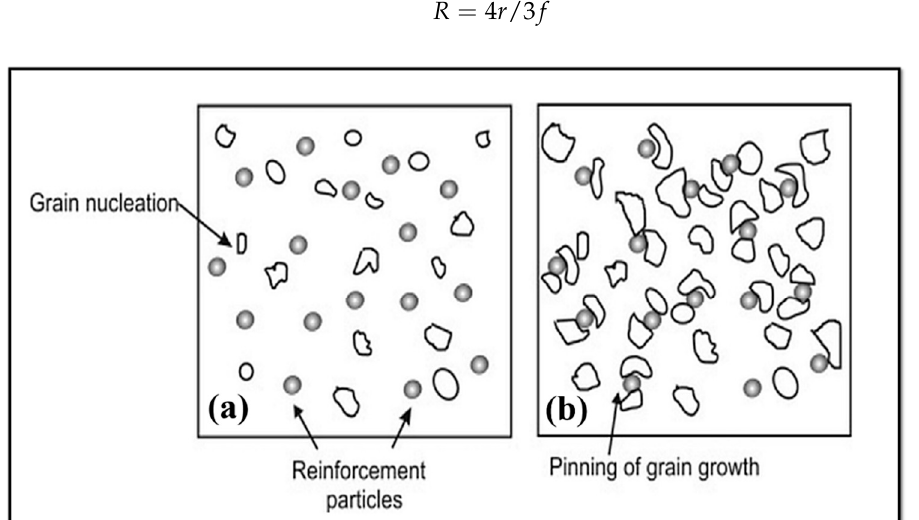
Figure 5. Retardation mechanism in grain growth during composite manufacturing in FSW/FSP technique: ( a ) grains nucleation and ( b ) pinning of grain boundaries due to reinforcements (Reprinted with permission from ref. [95]. Copyright 2015 Elsevier Table 2. Grain size evolution during FSW through addition of reinforcements.